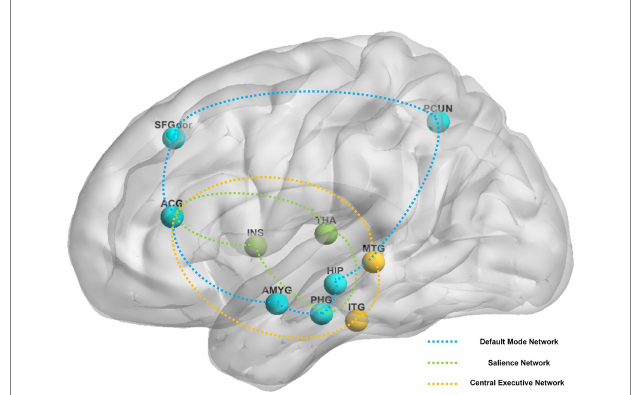
FIGURE 3 The main reported alternation of brain regions and networks by sustained acupuncture across the studies reviewed. Brain regions: ACG, anterior cingulate and paracingulate gyri; AMYG, amygdala; HIP, hippocampus; INS, insula; ITG, inferior temporal gyrus; MTG, middle temporal gyrus; PCUN, precuneus; PHG, parahippocampal gyrus; SFGdor, superior frontal gyrus, dorsolateral; THA, thalamus. Brain networks: blue network, default mode network; green network, salience network; yellow network, central executive